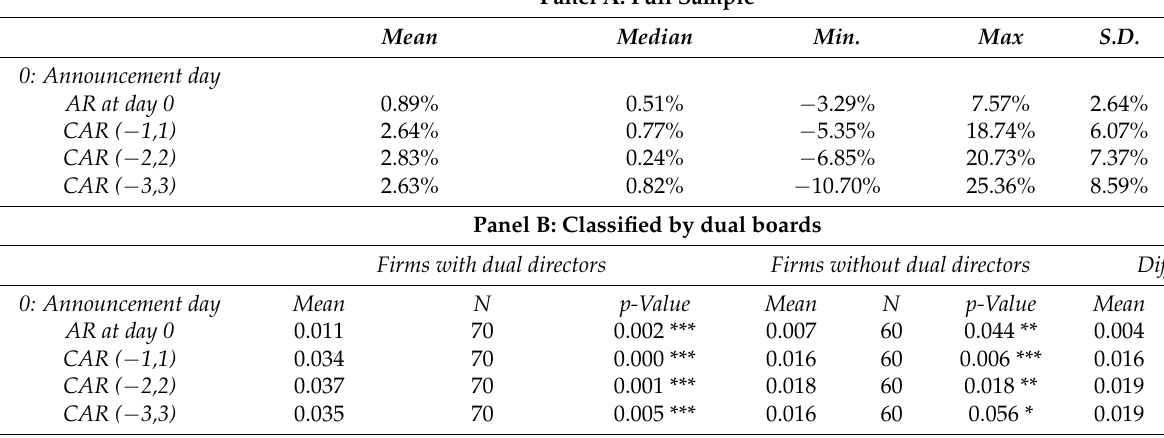
Table 4. Excess stock returns surrounding announcements of equity carve-outs. AR (abnormal return) and cumulative abnormal returns (CAR) are calculated using the parameters of the five-factor model estimated over the period from − 273 to − 22 days in which the announcement day is defined as 0. Panel A reports the full sample result. Subsamples are formed according to the presence of dual directors. Panel B compares firms with dual directors and those without. Panel C classifies firms based on the presence of dual directors holding CEO position in the subsidiary firms. Panel D classifies firms based on the presence of young dual directors holding CEO position in the subsidiary firms. Panel E classifies firms based on the presence of dual directors holding the non-CEO position in subsidiary firms. Panel F classifies firms based on the presence of young dual directors holding the non-CEO position in subsidiary firms. The significance of the means is tested using a t-statistic . All the variables are winsorized at the top and bottom five percent values. *, **, and *** indicate significance at the 10%, 5%, and 1% levels, respectively. Panel A: Full Sample Mean Median Min. Max S.D. N